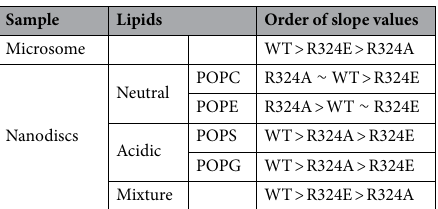
Figure 4. Relationship between logarithm of EP transition rates of expressed Ca 2+ -ATPases and square of mean activity coefficient γ ± 2 . ( a ) EP transition time courses of microsomes were measured in the presence of 0.1 M KCl at 0 °C. Microsomes were incubated in 10 μM CaCl 2 . Then the mixture was mixed with the medium containing [γ- 32 P]ATP and EGTA. Finally, the reaction mixture contained 50 mM MOPS/Tris (pH 7.0), 0.1 M KCl, 7 mM MgCl 2 , 2 mM EGTA, 5 μM CaCl 2 and 10 μM [γ- 32 P]ATP (free Ca 2+ < 1 nM). The reaction was terminated by 7% TCA at the indicated time after ATP-EGTA addition and the amount of EP was measured. The solid lines show the least squares fit to a single exponential decay. ( b ) EP transition rates were determined with wild type and mutants in various concentrations of KCl as indicated, and their logarithms are plotted versus γ ± 2 as previously described 21 . The values presented are the mean ± SD (n = 3–5). Solid lines show the least square fit in a linear regression, and the fitting parameters (± SEM), the slope and the intercept at γ ±2 = 0, are listed in Supplementary Table S4. ( c ) from rate versus activity coefficient plot of Ca 2+ -ATPase embedded in nanodiscs harboring various phospholipids are shown as bar graphs (see Supplementary Fig. S4). The error bars indicate ± SEM. The parameters are also listed in Supplementary Table S4. ( d ) The difference between the slopes of wild type and mutants (Δslope) are shown.